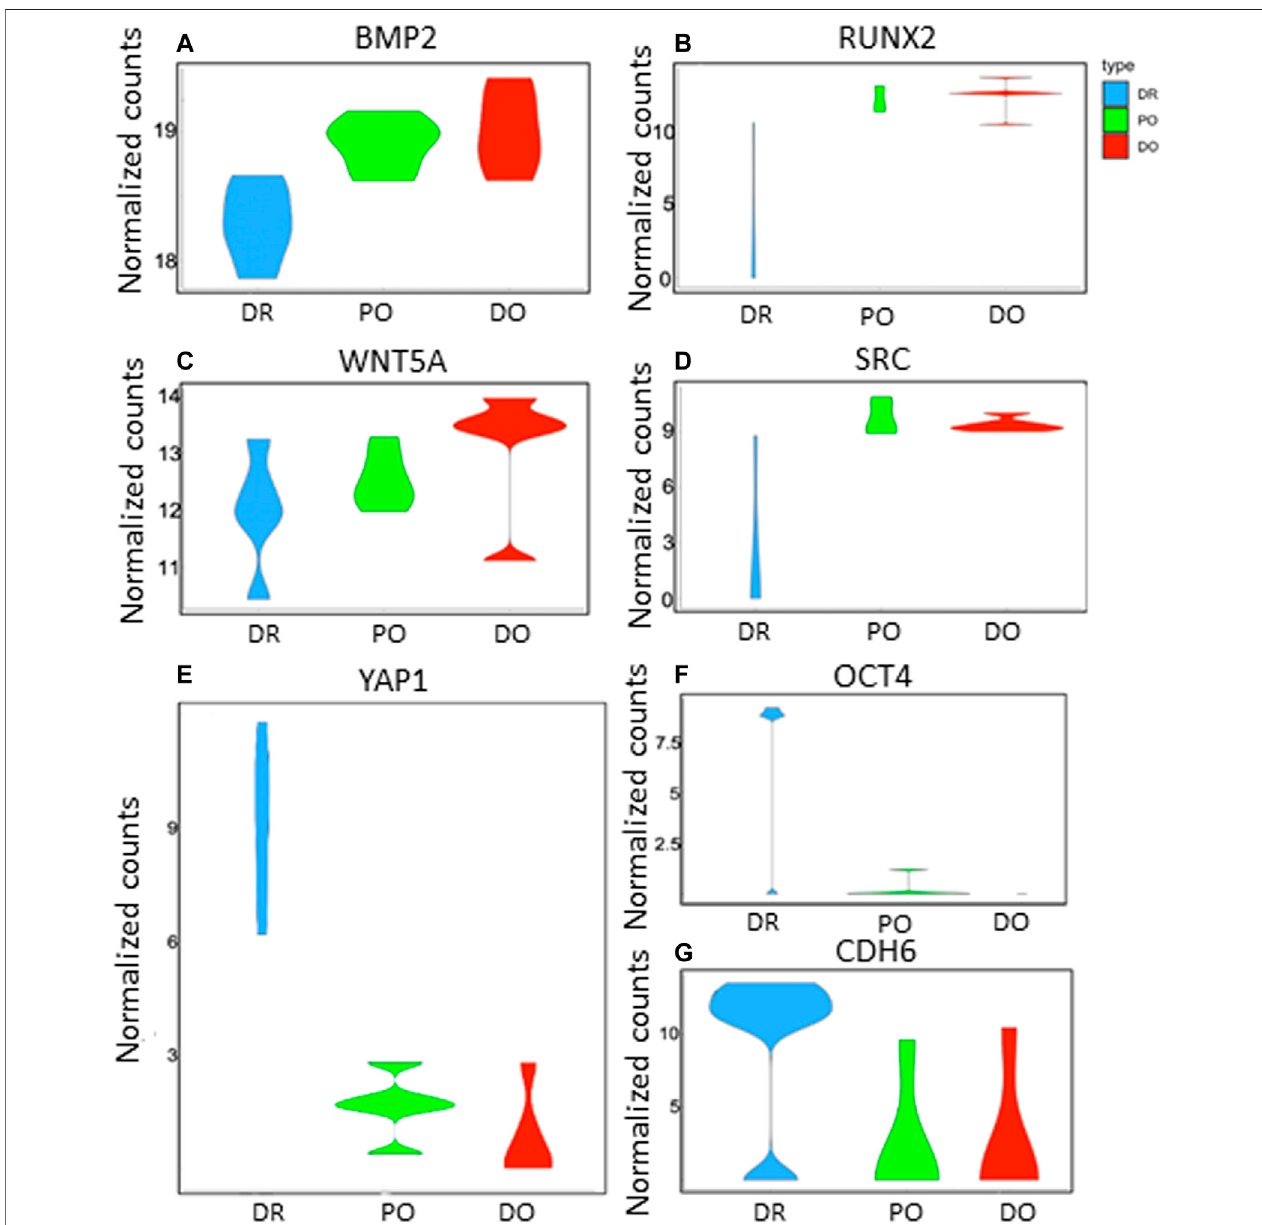
FIGURE 3 | Gene expression pro fi les of DR, PO, and DO clusters. The violin plots show the distribution of key gene expressions in single cells from differentiation resistant MSCs (DR, blue), precursor osteoblasts (PO, green), and differentiated osteoblasts (DO, red). p -values represent differences of DR cluster compared to PO cluster and DO cluster respectively as follows: (A) BMP2 (3.8E-4; 2.9E-4), (B) RUNX2 (0.05; 0.04), (C) WNT5A. (0.04; 0.037), (D) SRC (4.8E-2; 3.2E-2). (E) YAP1 is signi fi cantly elevated in DR-MSCs compared to PO and DO ( p = 0.03; p = 0.032, respectively). (F) Transcription factor OCT4 was signi fi cantly upregulated in DR- MSCscomparedtoPOandDO( p =0.0168; p =0.0161,respectively). (G) CDH6expressionwasalsomarkedlyhigherintheDRMSCclusterwhencomparedtoPOand DO ( p = 0.0366; p = 0.0324, respectively).